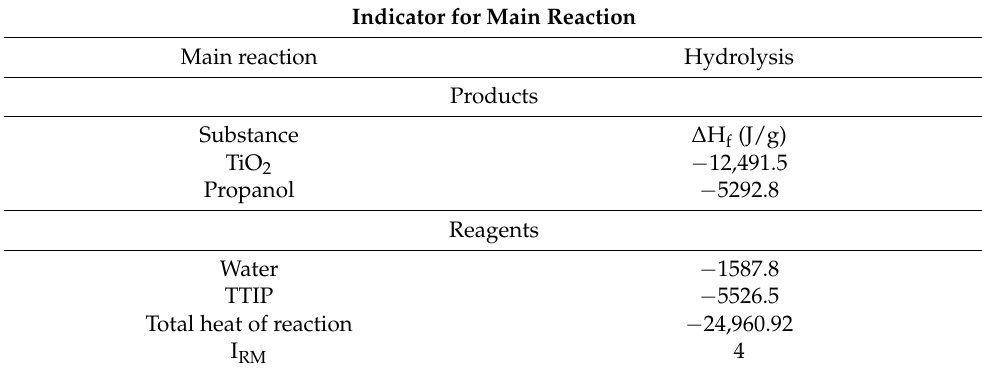
Table 3. Heat of reaction for the hydrolysis